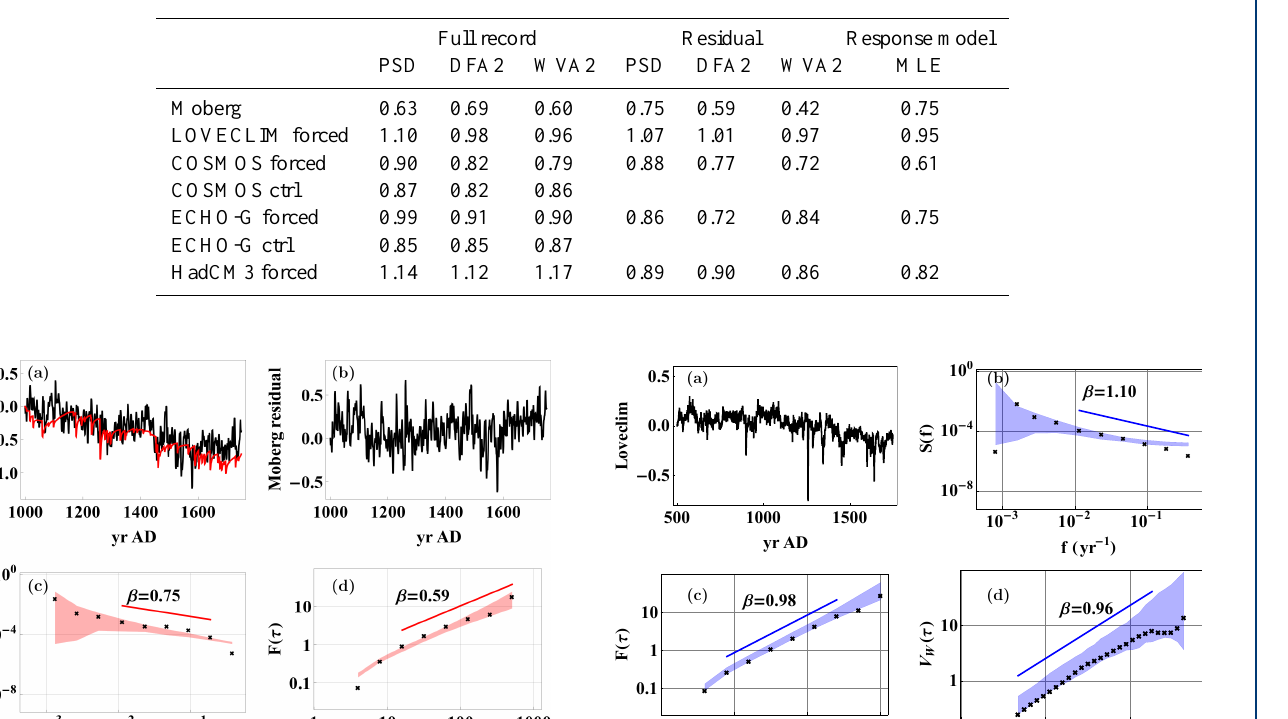
Table 2. Estimated β from applying the PSD, DFA2 and WVA2 directly to the full temperature record (all temperatures), from PSD, DFA2 and WVA2 applied to the residuals from the deterministic response, and from the response model using MLE (temperature reconstruction and temperature from the forced climate model run experiments). The error bars on all estimates are approximately 1β ± 0 . 2 (see main text).